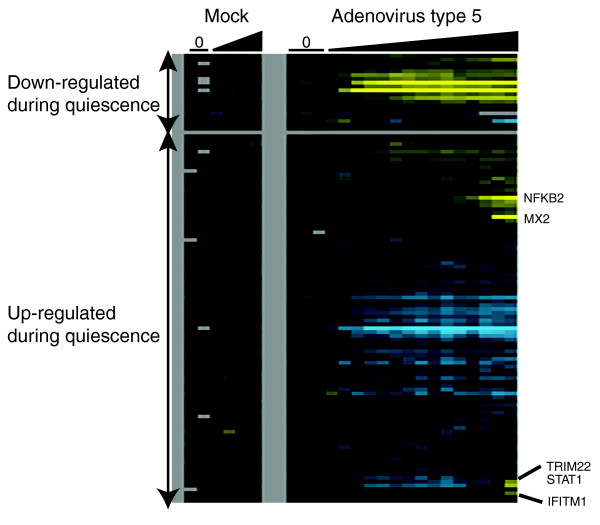
Ad5 infection induces reversal of the quiescence program. The expression responses of the quiescence program genes to adenovirus type 5 (Ad5) infection were isolated, and divided into two groups on the basis of expression changes during quiescence. The members of each group (downregulated during quiescence and upregulated during quiescence) were then hierarchically clustered and the two groups then rejoined for visualization. The genes named at the right are discussed in the text. Ramps above panels indicate increases in time after infection.